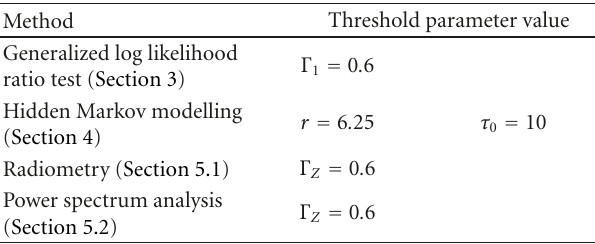
Table 1: Optimum threshold parameter for each classification method, being that value for which the probabilities of type I and type II errors were most similar for a standard interferer at INR of